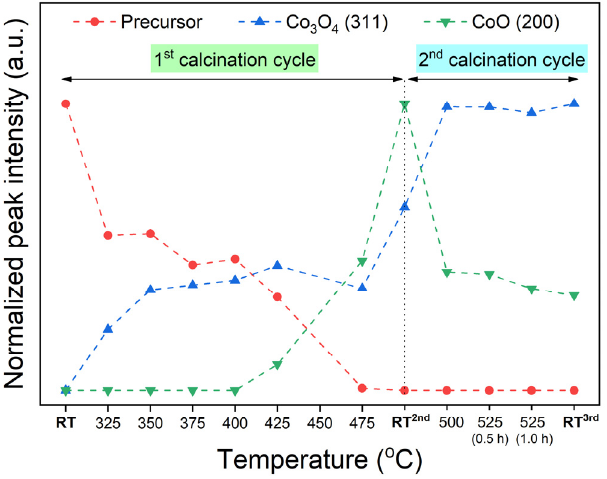
Figure 2. A profile of normalized XRD intensities, deriving from in-situ XRD data (Figure 1), repre- sents the progress of phase transformation of the CCO precursor by elevating calcination tempera- ture.